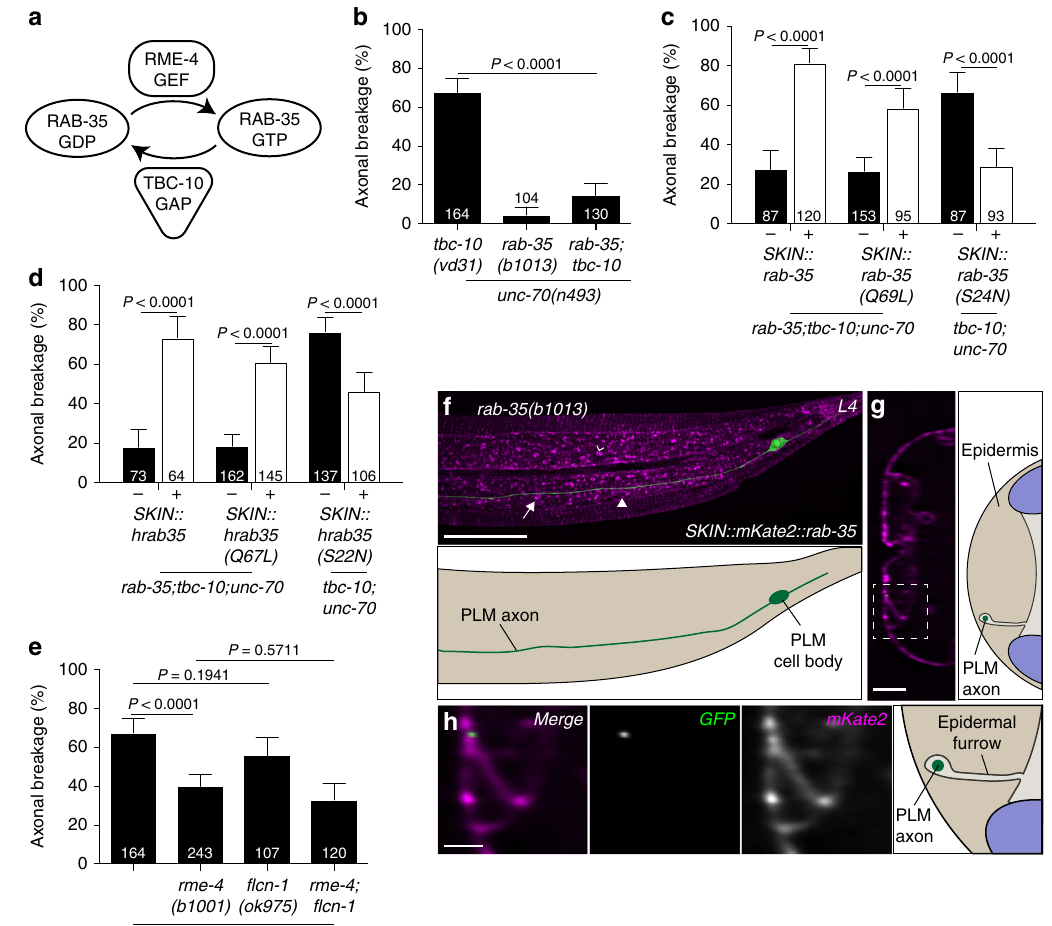
Fig. 3 TBC-10 is a RAB-35-speci fi c GAP. a Scheme of the activation cycle of RAB-35. b Mean penetrance of axonal breaks in unc-70(n493) mutants with and without mutations in tbc-10(vd31) and rab-35(b1013) . c Mean penetrance of axonal breakage in rab-35(b1013);tbc-10(vd31);unc-70(n493) or tbc-10(vd31); unc-70(n493) mutants carrying transgenes expressing either the wild-type C. elegans rab-35 , a constitutively active rab-35(Q69L) mutant, or a constitutively inactive rab-35(S24N) mutant under the control of an epidermal-speci fi c promoter, versus respective non-transgenic siblings. d Mean penetrance of axonal breakage in rab-35(b1013);tbc-10(vd31);unc-70(n493) or tbc-10(vd31);unc-70(n493) mutants carrying transgenes expressing either the wild-type human rab35 , a constitutively active human rab35(Q67L) mutant, or a constitutively inactive human rab35(S22N) mutant under the control of an epidermal-speci fi c promoter, versus their respective non-transgenic siblings. e Mean penetrance of axonal breaks in tbc-10(vd31);unc-70(n493) mutants, with and without single or double mutants for rme-4 and fl cn-1 . P -values in b and e are determined from a one-way ANOVA with a Tukey multiple-comparison of proportions using an Agresti – Coull interval. P -values in c and d determined from a comparison of proportions using an Agresti – Coull interval. Error bars indicate a 95% con fi dence interval. Source data are provided as a Source Data fi le. f Deconvolved spinning disk confocal maximum projection and scheme of mKate2:: RAB-35 localization (magenta) expressed under an epidermal-speci fi c promoter in a typical rab-35 mutant animal with the PLM neuron labeled with a cytosolic GFP ( Pmec-4::GFP ). Tubular, punctate, and spherical structures labeled with an arrow, closed arrowhead, and open arrowhead respectively. g An orthogonal perspective and scheme of mKate2::RAB-35 localization in the projected z -stack shown in f . h A high-magni fi cation image and scheme of the boxed area in g . These micrographs are representative of the mKate2::RAB-35 localization seen in N = 5 animals at the L4 stage. Scale bars are 25 μ m in f , 5 μ m in g , and 2 μ m in h . N -values are indicated on bar graphs and represent the number of individual animals scored for each